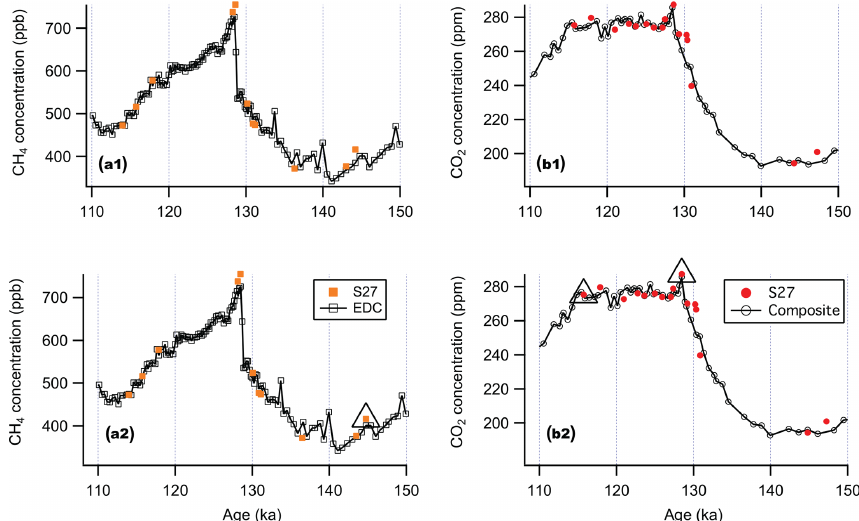
Figure 5. CH 4 and CO 2 measured in S27 plotted on the timescale developed solely on δ 18 O atm (a1, b1) and on the chronology after greenhouse gas synchronization (a2, b2) . Tie points and anchor points are marked in triangles. EDC CH 4 data are from Loulergue et al. (2008), composite CO 2 data from multiple ice cores are from Bereiter et al. (2015) and references therein, and the timescale (AICC2012) is from Veres et al. (2013) and Bazin et al.